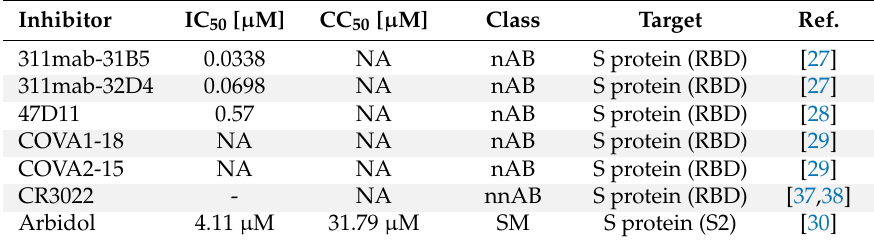
Table 1. Antibodies and small molecules targeting the SARS-CoV-2 S-protein.